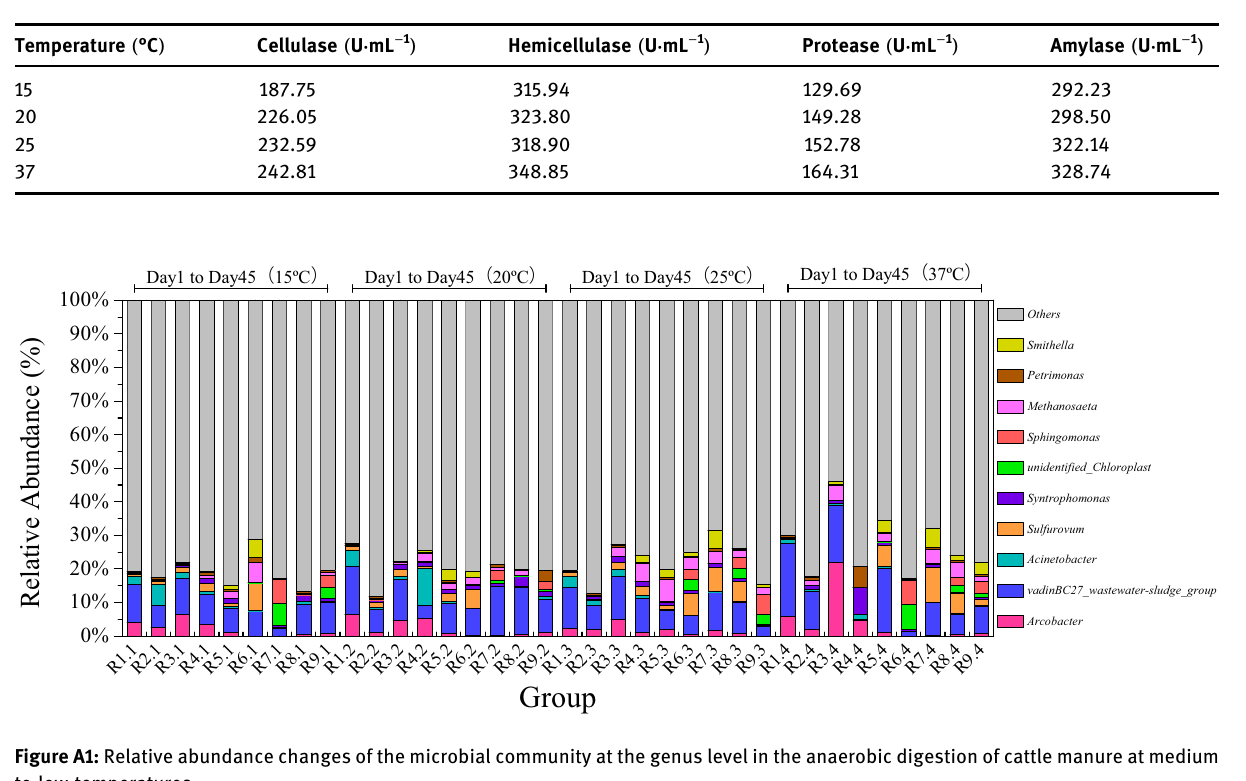
Table A1: Maximum activities of di ff erent enzymes in the anaerobic digestion of cattle manure at medium to low temperatures